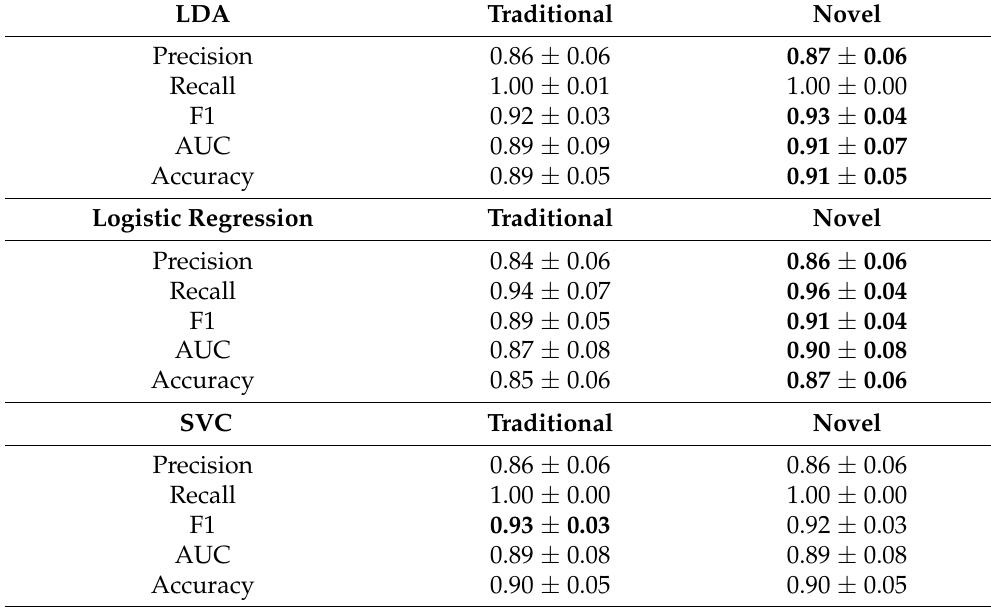
Table 3. Performance metrics for the TFM and NFM with three different classification models. Each value is the mean of 10-fold cross-validation plus or minus the standard deviation. The values in bold font are higher than their counterparts in the other